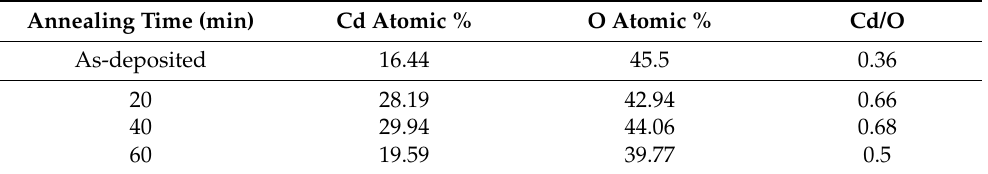
Table 4. Compositional analysis of CdO thin films at different annealing times.